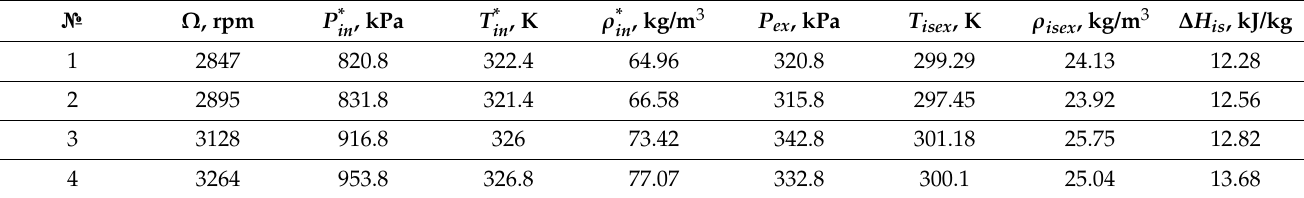
Table 7. ORC microturbine operational regimes. Inlet/outlet boundary conditions and isentropic quantities.